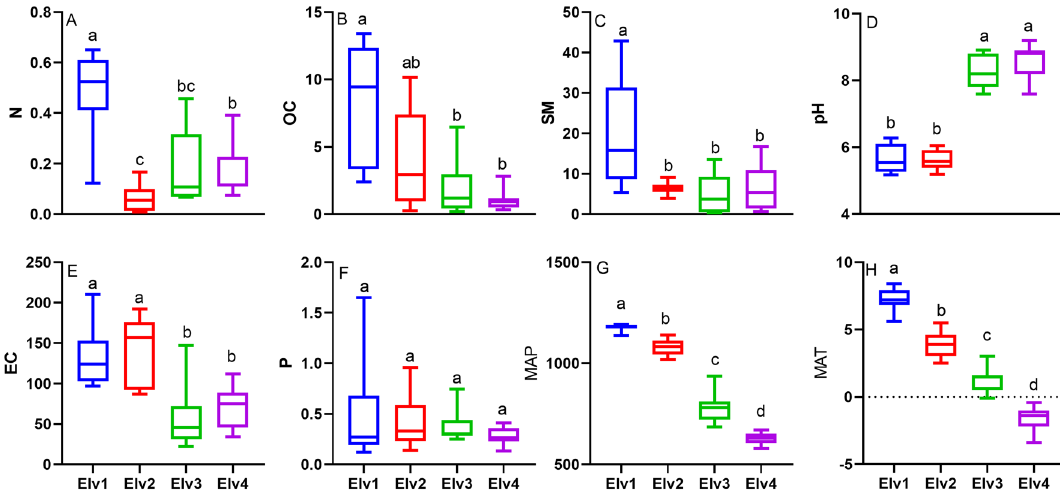
Figure 1. Soil parameter across elevation. Elv—Elevation class; ( A ) N—Nitrogen content (%); ( B ) OC—soil organic carbon (%); ( C ) SM—soil moisture (%); ( D ) Soil pH; ( E ) EC—electric conductivity (µS cm −1 ) and ( F ) P—phosphorus content (%) across elevation classes. Different small case letters across a panel denote significant